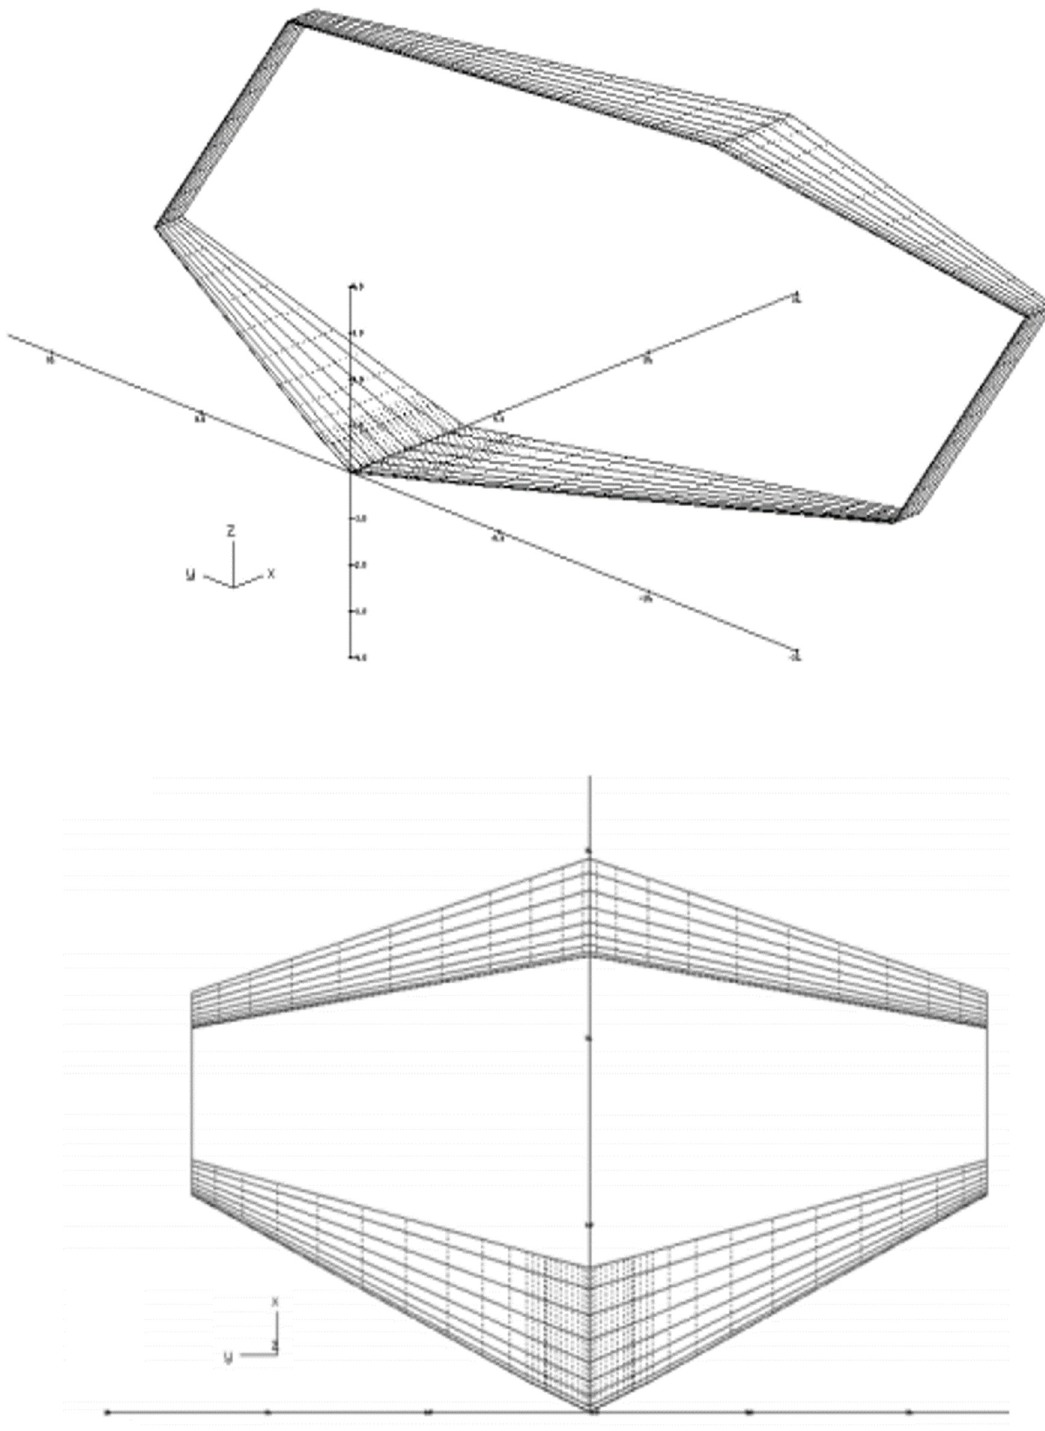
Fig. 6. An example of Prandtl Plane wing con fi guration de fi ned in AVL for the THEA-CODE work fl